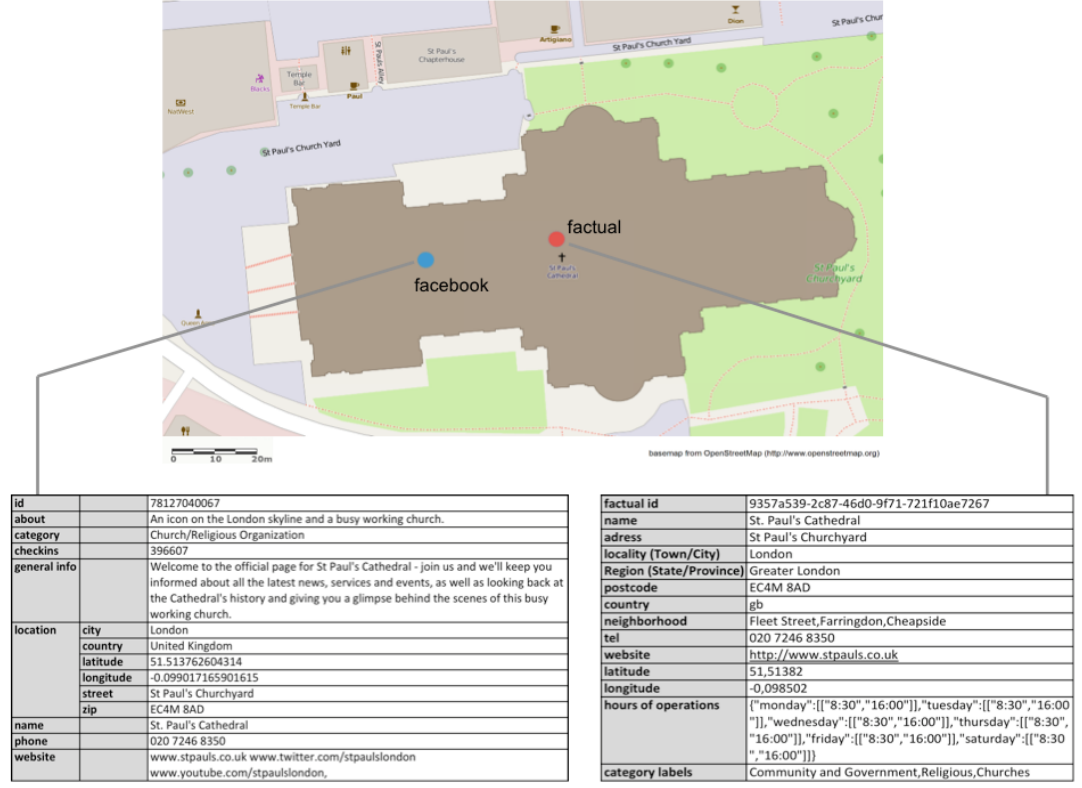
Figure 1. POI Co-referents from Facebook and Factual.